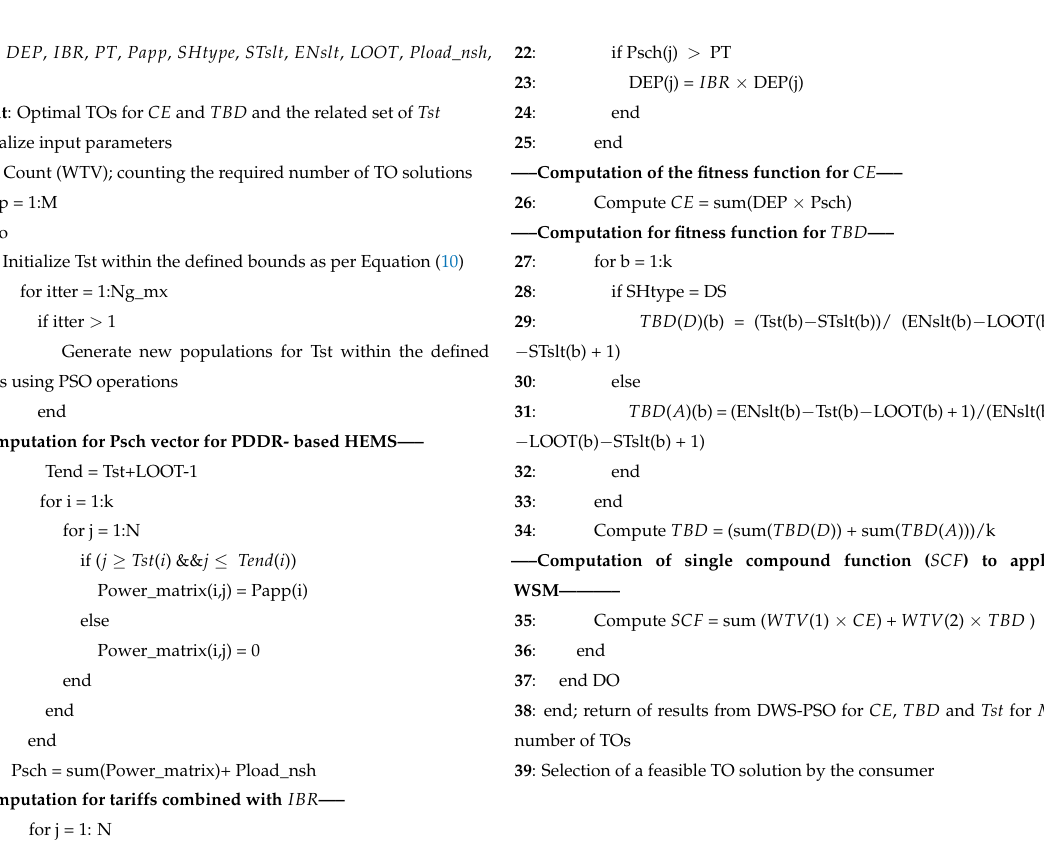
Algorithm 1 Algorithm for a PDDR-based HEMS using